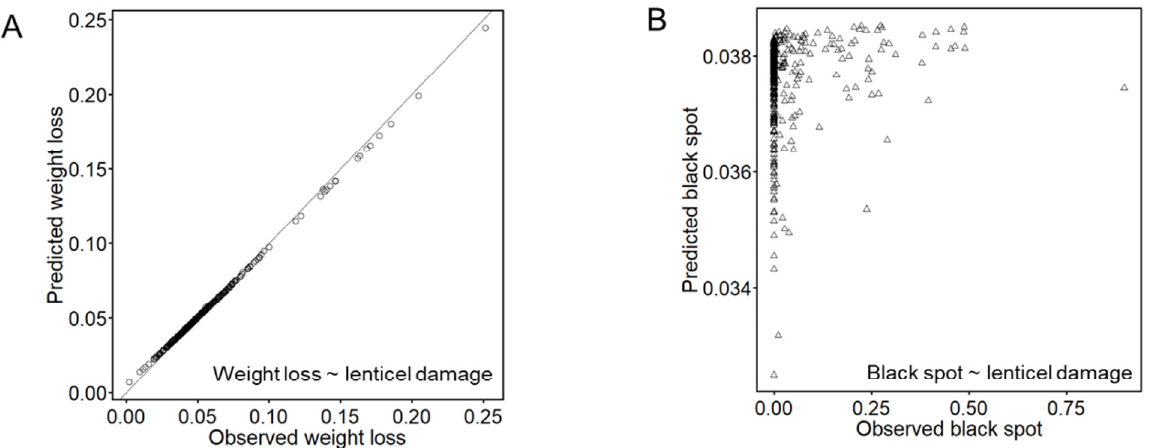
Figure 6. Predicted and observed values of ( A ) weight loss and ( B ) black spot as a function of lenticel damage. Predicted values were obtained as a posterior mean after an MCMC procedure using a Bayesian framework.